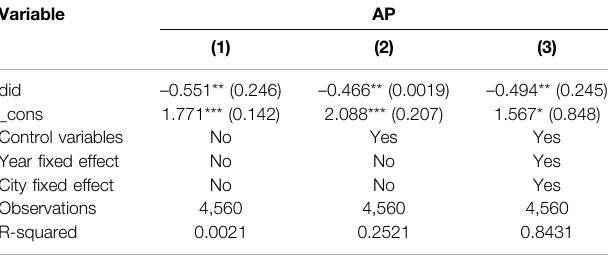
TABLE 2 | Baseline results of NIRDZs policy on SO2 emissions.